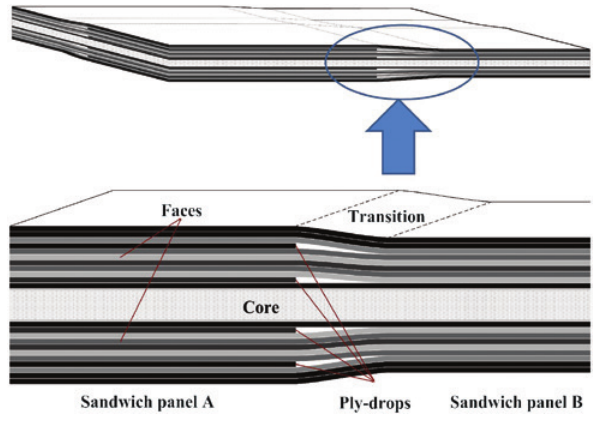
Figure 1: Ply drops between adjacent sandwich panels with identical core thicknesses.